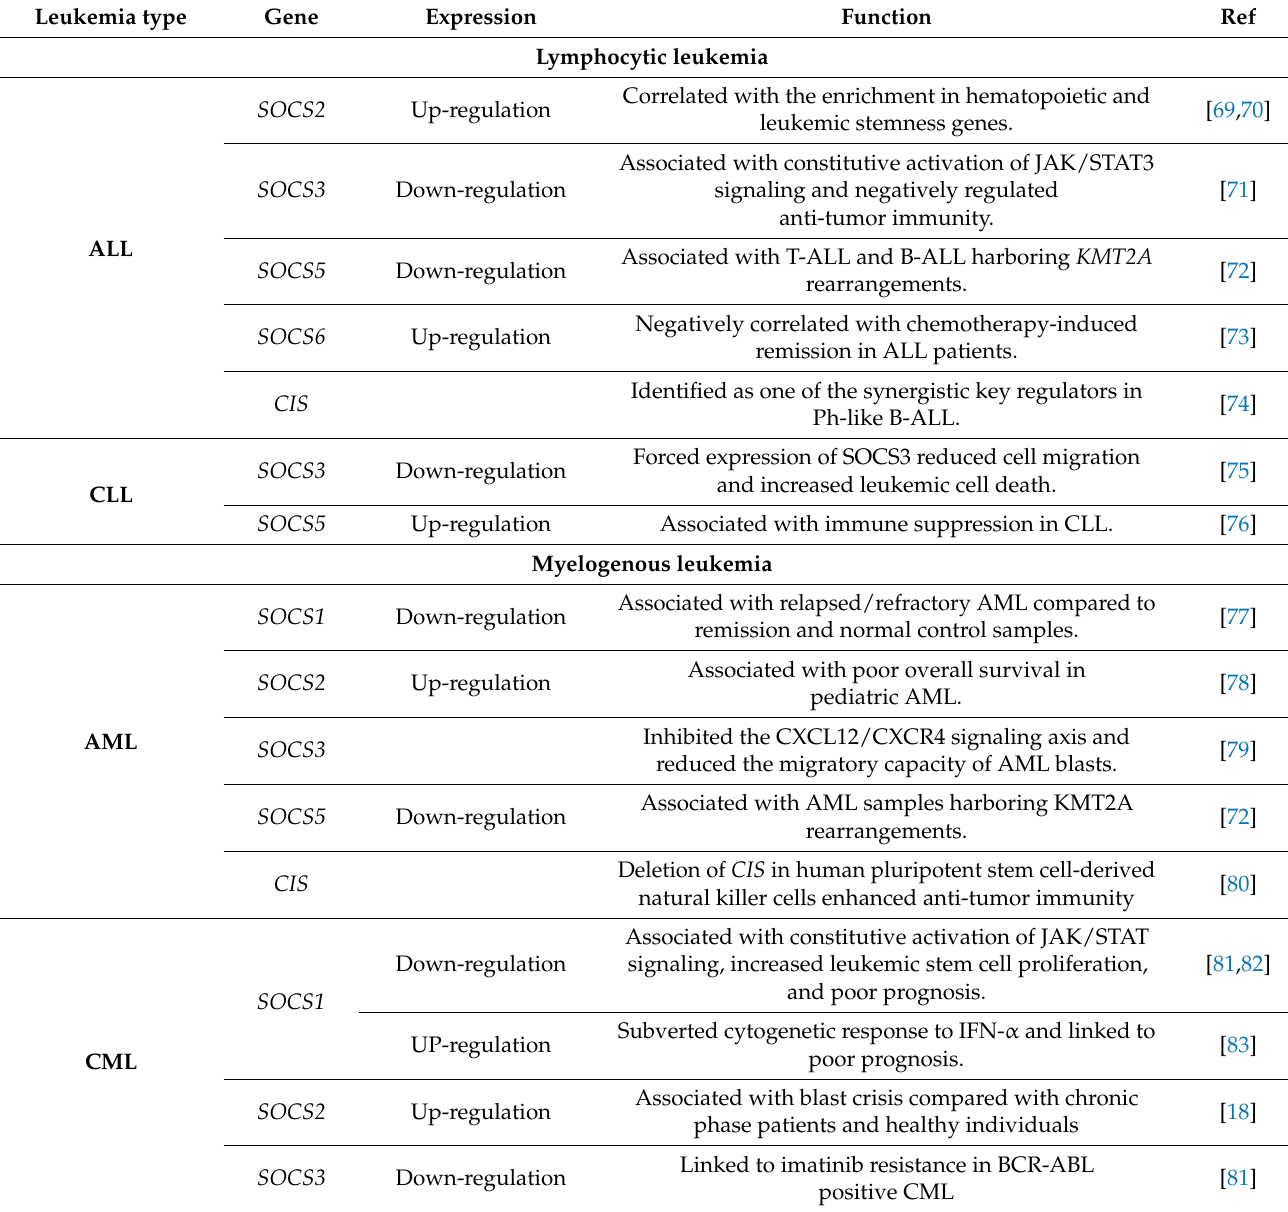
Table 2. Biological and clinical significance of the suppressors of cytokine signaling (SOCS) in leukemia. Leukemia